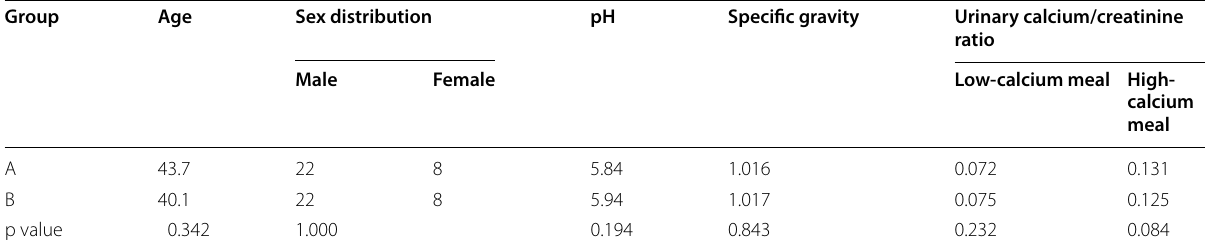
Table 1 Comparison of mean values between the two groups Group